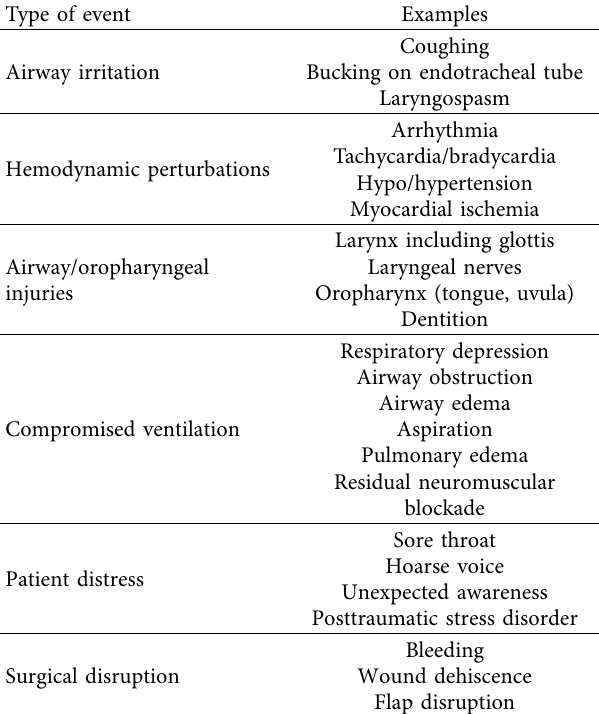
Table 1: Adverse events associated with